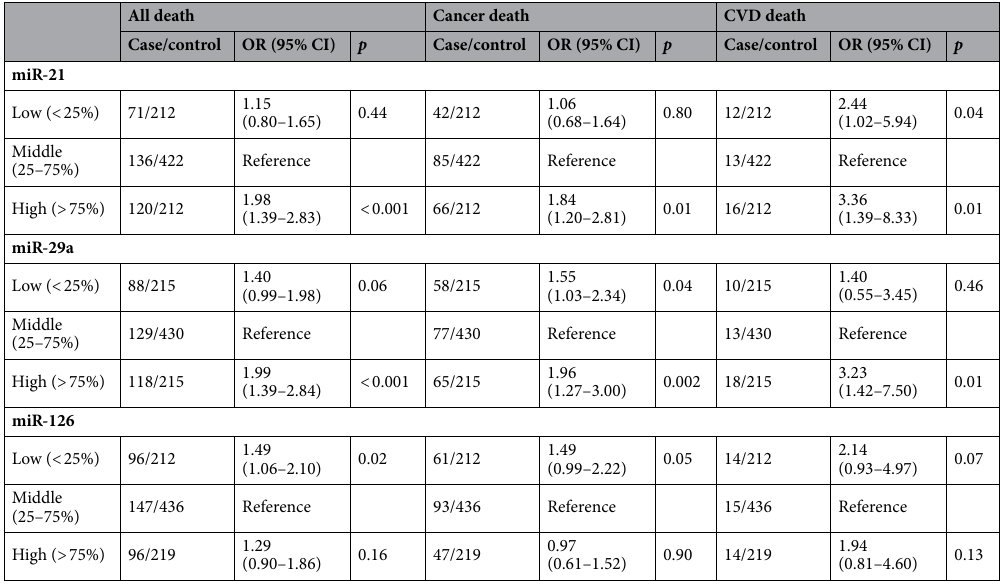
Table 3. The ORs and 95% CIs for premarture death following analysis by the multivariable logistic regression model. Adjustment for sex, age, study site, systolic blood pressure, body mass index, smoking status, drinking status, leisure time activity, and educational level. CVD cardiovascular